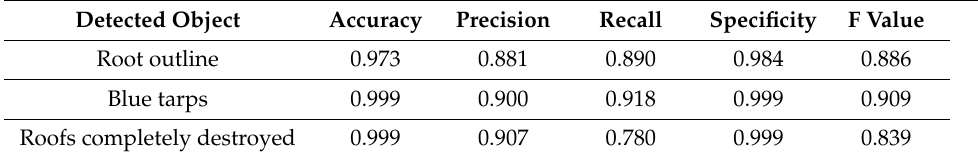
Table 5. Evaluation results of each detection target.